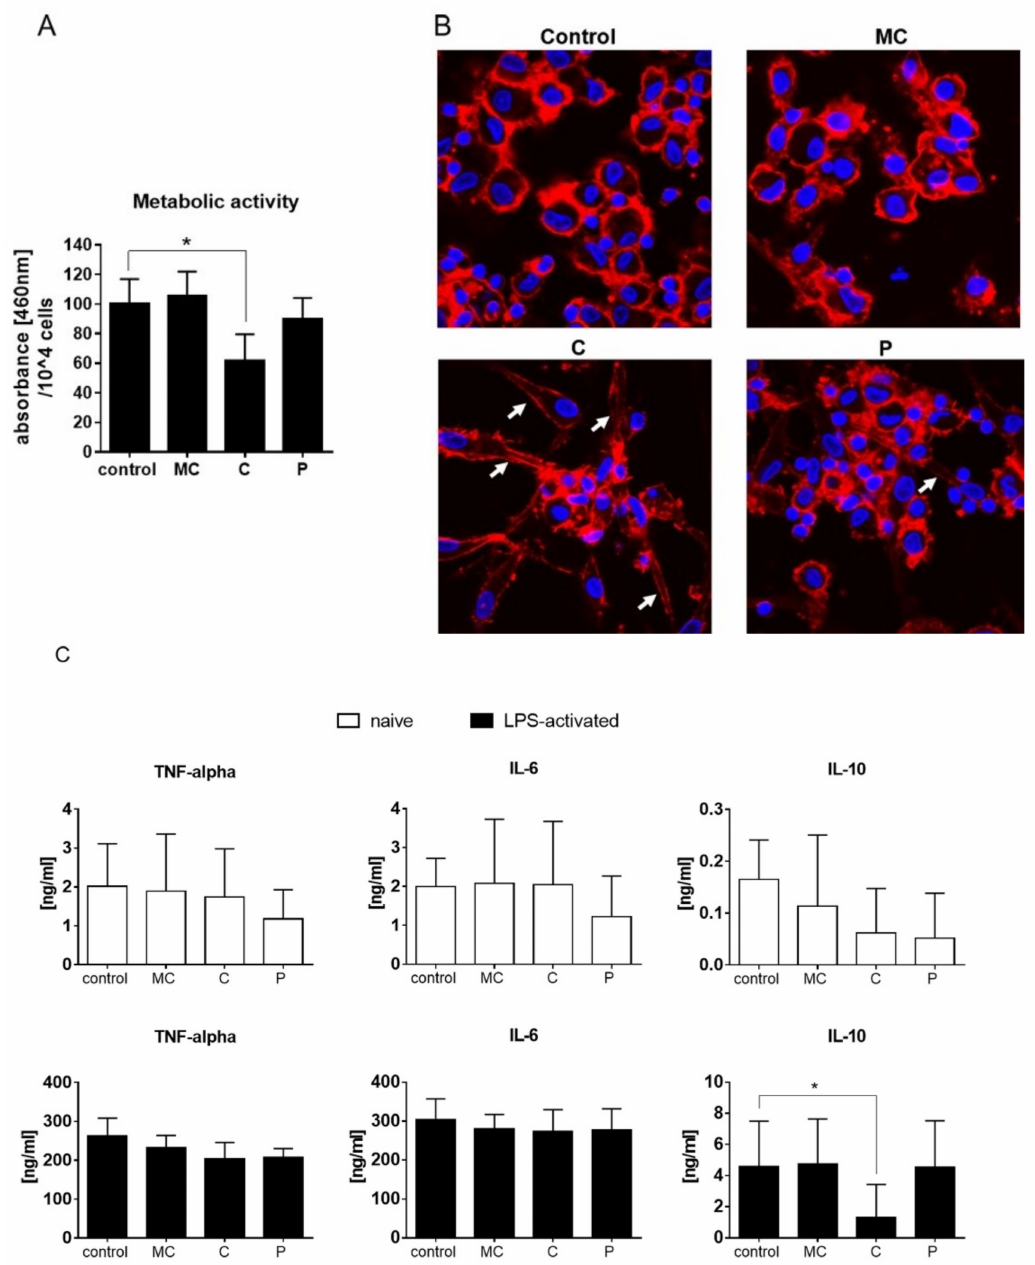
Figure 8. ( A ) XTT assay for metabolic activity of LPS-activated human dendritic cells stimulated with vehicle, MC extract, C extract, or P extract (60 µ g/mL) for 48 h. ( B ) Representative confocal microscopic pictures of LPS-activated human dendritic cells treated with vehicle, MC extract, C extract, or P extract (60 µ g/mL) for 48 h (blue = DAPI (Nulcei), red = phalloidin (F-actin); Magnification 63X; White arrows indicates endocytic enlargement). ( C ) Quantification of cytokines in the supernatant of LPS-activated human dendritic cells stimulated with vehicle, MC extract, C extract, or P extract (60 µ g/mL) for 24 h (* p ≤ 0.05, n =